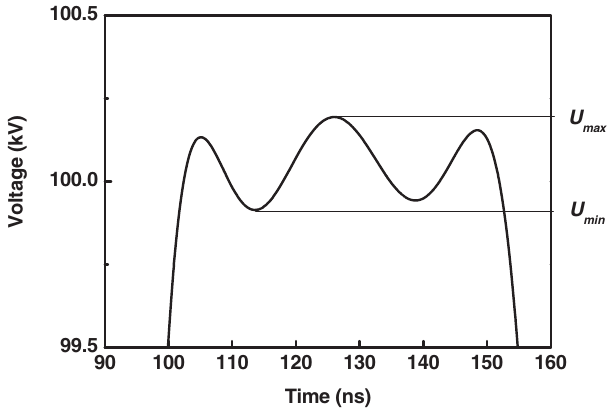
FIG. 5. Definition of the maximal U amplitude of the voltage pulse across the resistive load R in Eq.